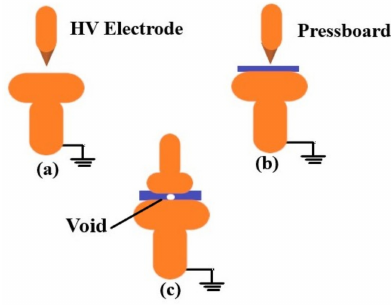
Figure 2. Generated PD ( a ) sharp point to plane electrode ( b ) surface discharge ( c ) void discharge.